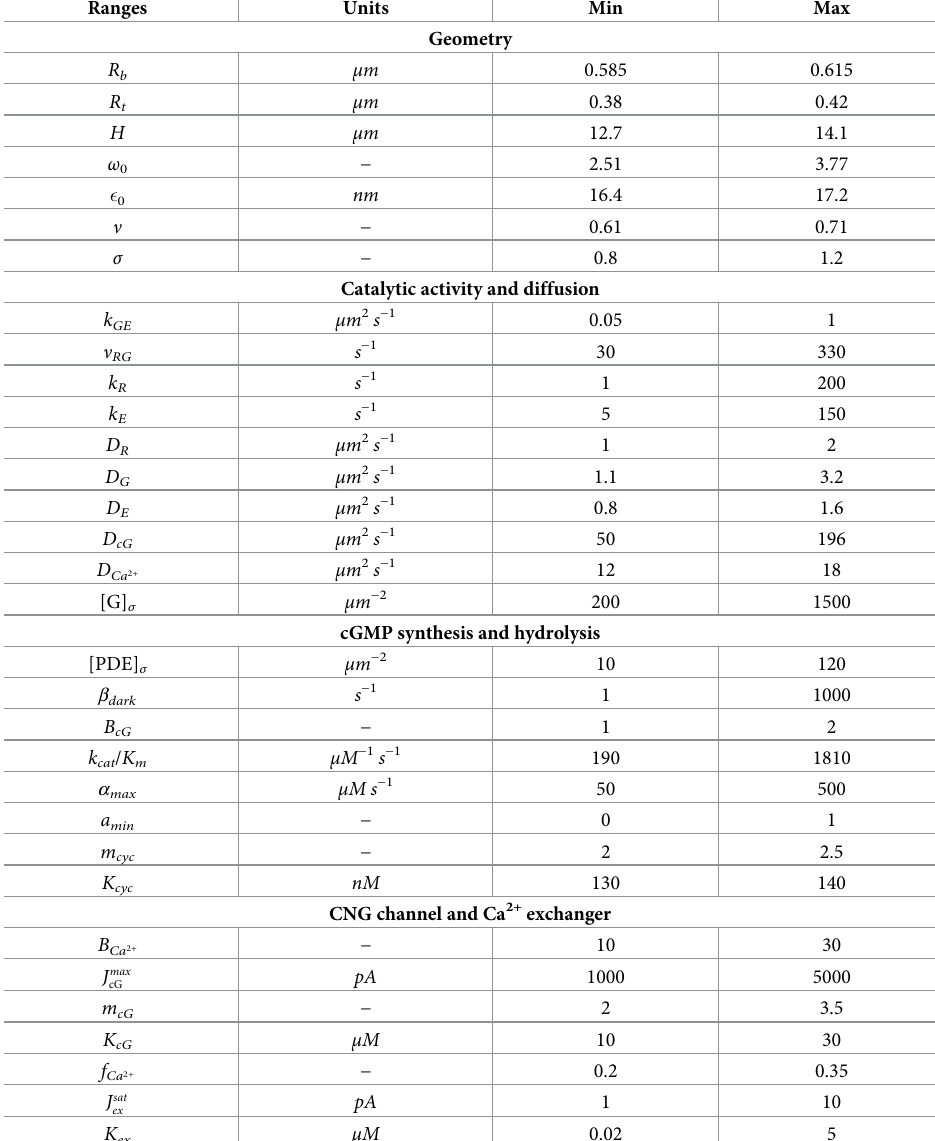
Table 9. Ranges over which parameters were varied when conducting Sobol sensitivity analysis.